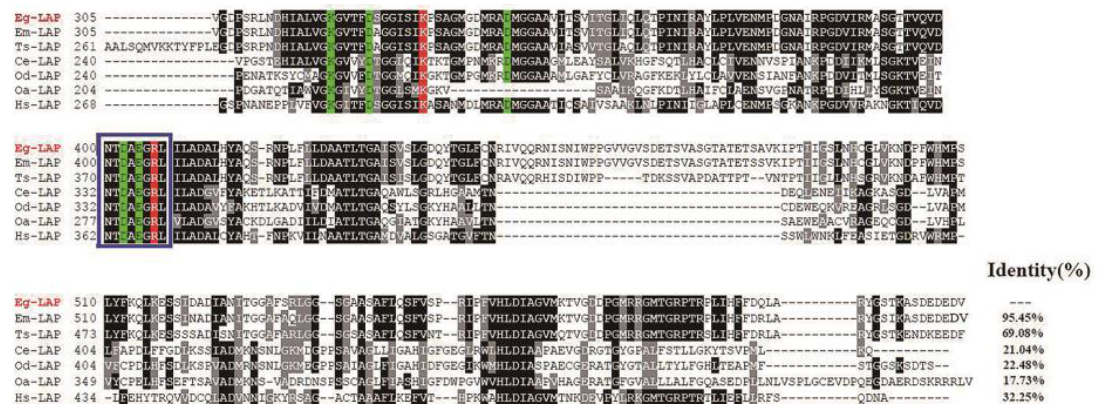
Figure 1. Sequence alignment analysis of Eg-LAP with homologous leucine aminopeptidases. Coherence of the deduced amino acid sequence of Echinococcus granulosus leucine aminopeptidase (GenBank: KX159768) with protein sequences from different species. The following sequences were retrieved from the GenBank, GeneDB and UniProt protein sequence databases: Echinococcus multilocularis leucine aminopeptidase (E.m-LAP) (GenBank: CDS43570.1), Taenia solium leucine aminopeptidase (T.s-LAP) (GeneDB: TsM_001140000), Caenorhabditis elegans (Ce-LAP) (GenBank: CCD73205.1), Oesophagostomum dentatum (Od-LAP) (UniProt: A0A0B1TS56), Ovis aries leucine aminopeptidase (Oa-LAP) (GenBank: XP_004014812.1) and Homo sapiens leucine aminopeptidase (Hs-LAP) (GenBank: AAD17527.1). Regions of high identity and similarity between leucine aminopeptidase sequences according to the Clustal X algorithm are shown as black and gray columns, respectively. The M17 family signature octapeptide NTDAEGRL sequence is marked with a blue box. The actin-binding motifs are in white letters with red backgrounds; the metal binding sites are in black letters with green backgrounds. The percentage homology of Eg-LAP with other species is shown at the end of the